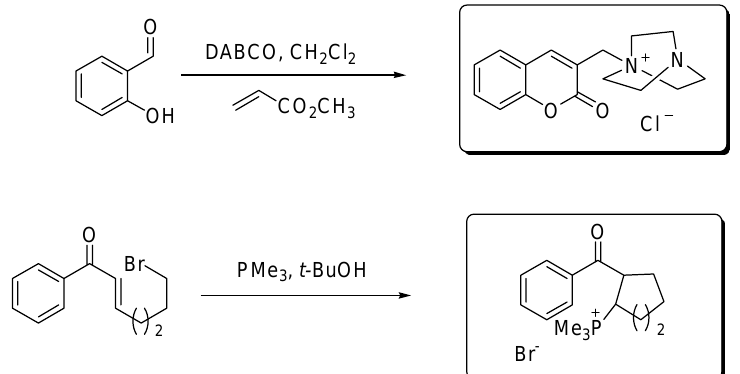
Figure 1. Isolated MBH intermediates 6 as proposed by